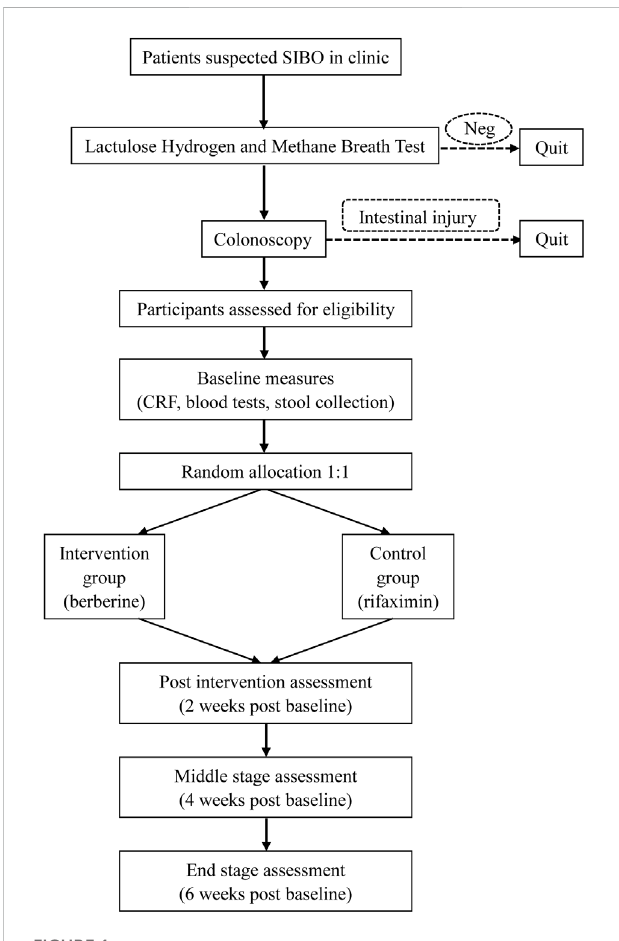
FIGURE 1 Flow diagram based on the Consolidated Standards of Reporting Trials guidelines (CONSORT): Neg, negative; CRF, case report